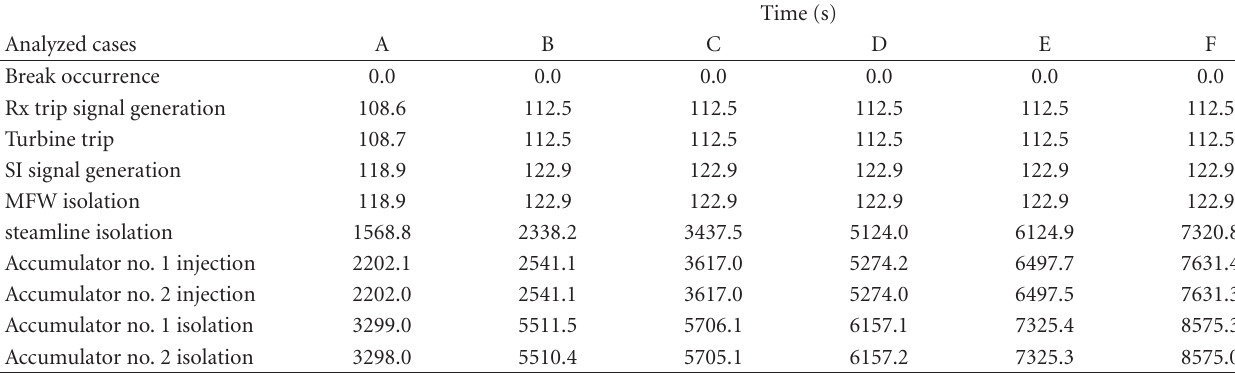
Table 3: Sequence of main events for 2.54 cm LOCA